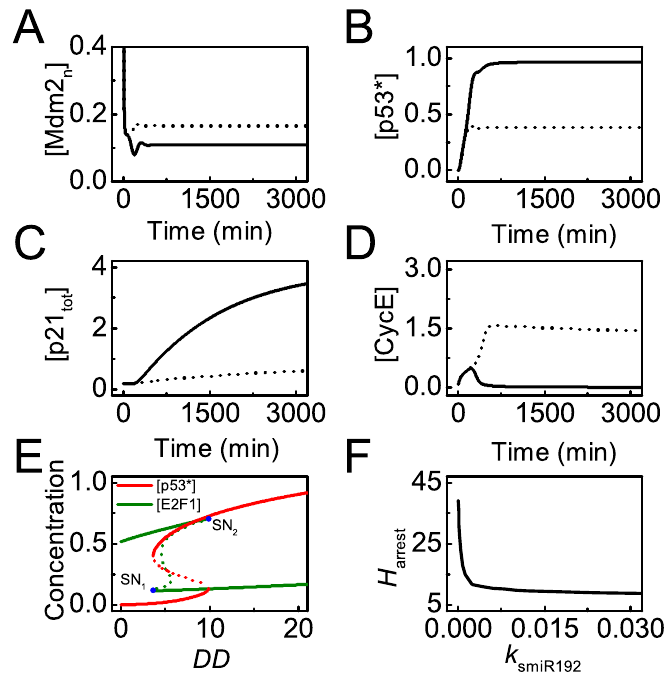
Figure 4. miR-192 promotes cell cycle arrest. ( A – D ) Time courses of [Mdm2 n ] ( A ), [p53 ∗ ] in ( B ), [p21 tot ] ( C ) and [CycE] ( D ) with the p53-induced synthesis rate of miR-192, k smiR192 = 0 (dash) and 0.01 (solid, the standard case) with DD = 25; ( E ) bifurcation diagrams of [p53 ∗ ] (red) and [E2F1] (dark green) versus DD . Blue dots mark saddle-node bifurcations (SN 1 , SN 2 ), and the value of DD at SN 2 refers to the threshold for cell cycle arrest, H arrest . ( F ) The curve of H arrest versus k smiR192